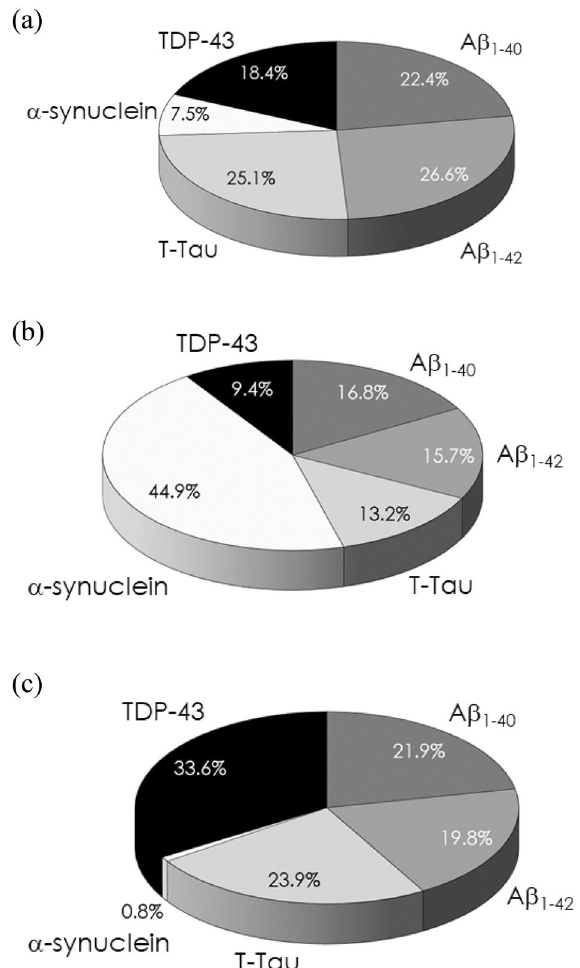
Figure 1. Dominance of plasma Aβ 1–40 , Aβ 1–42 , T-Tau, α-synuclein and TDP-43 in the ( a ) AD family, ( b ) PD family and ( c )